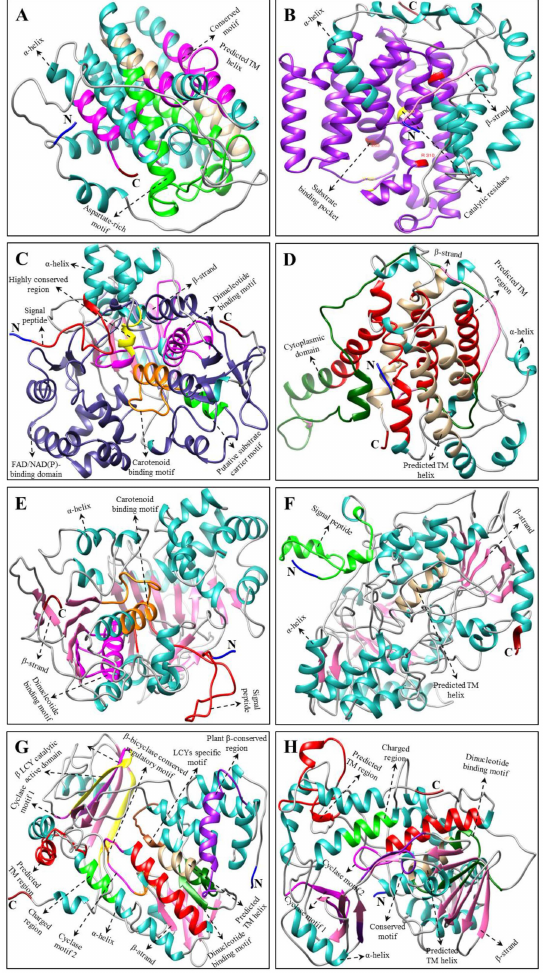
Figure 4. Tertiary structure of CP genes of H. moellendorffii . ( A ) HmGGPS , (B) HmPSY , ( C ) HmPDS , ( D ) HmZ-ISO , ( E ) HmZDS , ( F ) HmCrtISO , ( G ) HmLCYB , and ( H ) HmLCYE structures were created by using Chimera software (version 1.14) [62]. The amino (NH 2 ), carboxyl (COOH) termini, α -helices, and β -strands are shown in blue, red, green, and pink, respectively. Multiple alignments of each CP gene are shown in Figure